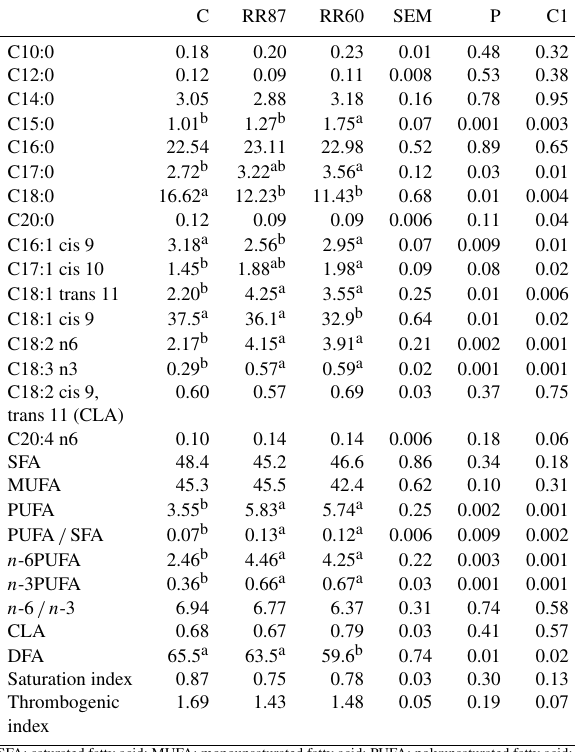
Table 5. Fatty acid profiles as % FAMEs (mg FAME per